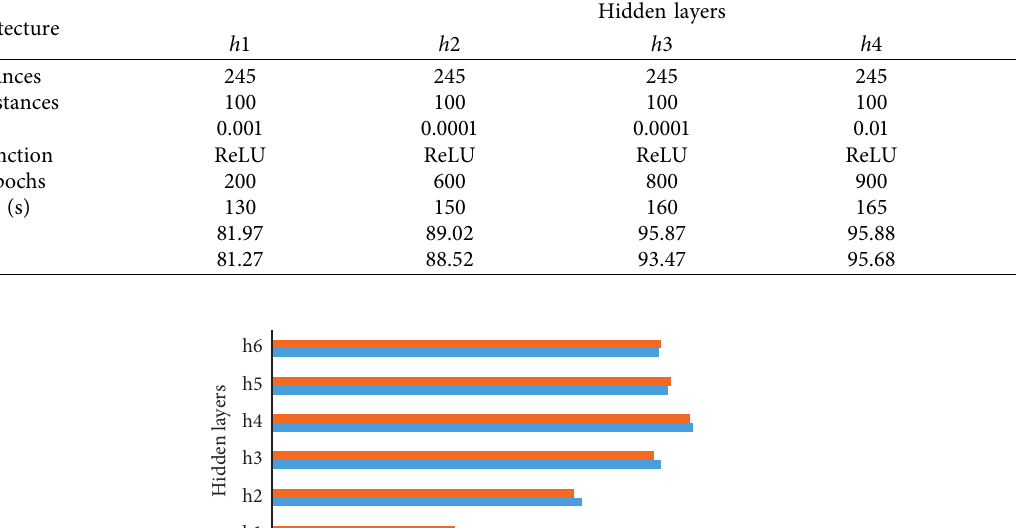
Table 2: Training parameters of the BLSTM